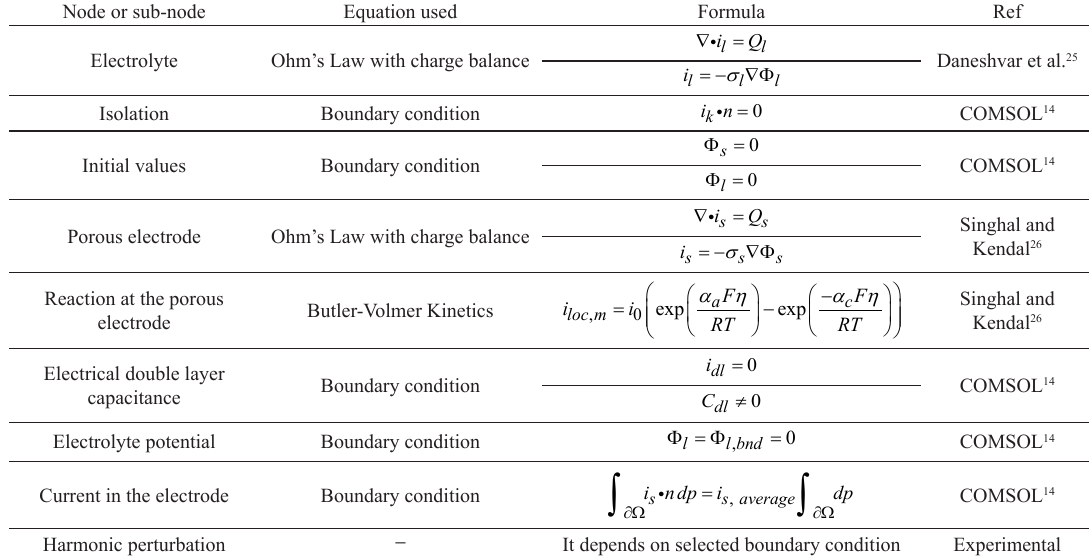
Table 3. Nodes, sub-nodes and equations used in the simulation interface. Node or sub-node